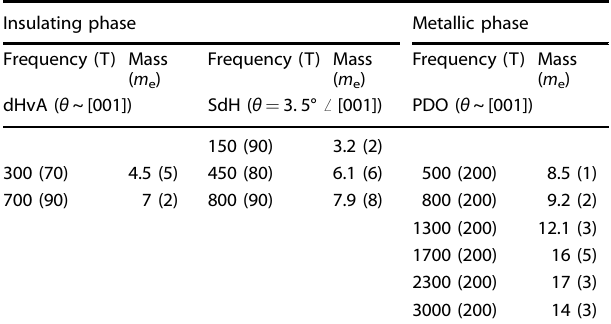
Fig. 3 FFT of quantum oscillations in insulating YbB 12 . FFT of quantum oscillations measured on insulating YbB 12 at a temperature of 0.3 K and fi eld range of 35 T < μ 0 H < 45 T in ( a ) magnetic torque, with the applied fi eld aligned close to the [001] crystallographic direction, and ( b ) electrical resistivity, with the applied fi eld aligned 3.5 ∘ away from the [001] crystallographic direction in the [001]-[111]-[110] rotation plane. The horizontal dashed lines indicate the FFT noise fl oors. Similar frequencies can be discerned in the two measured physical quantities. A summary of the multiple observed frequencies and their respective quasiparticle effective masses is shown in Table 1. An FFT decomposition involving LK simulations identi fi es a frequency ≈ 450 T in electrical resistivity that is visible as a shoulder of the main peak. Table 1. Observed multiple quantum oscillation frequencies and effective masses in the insulating and metallic phases of YbB 12